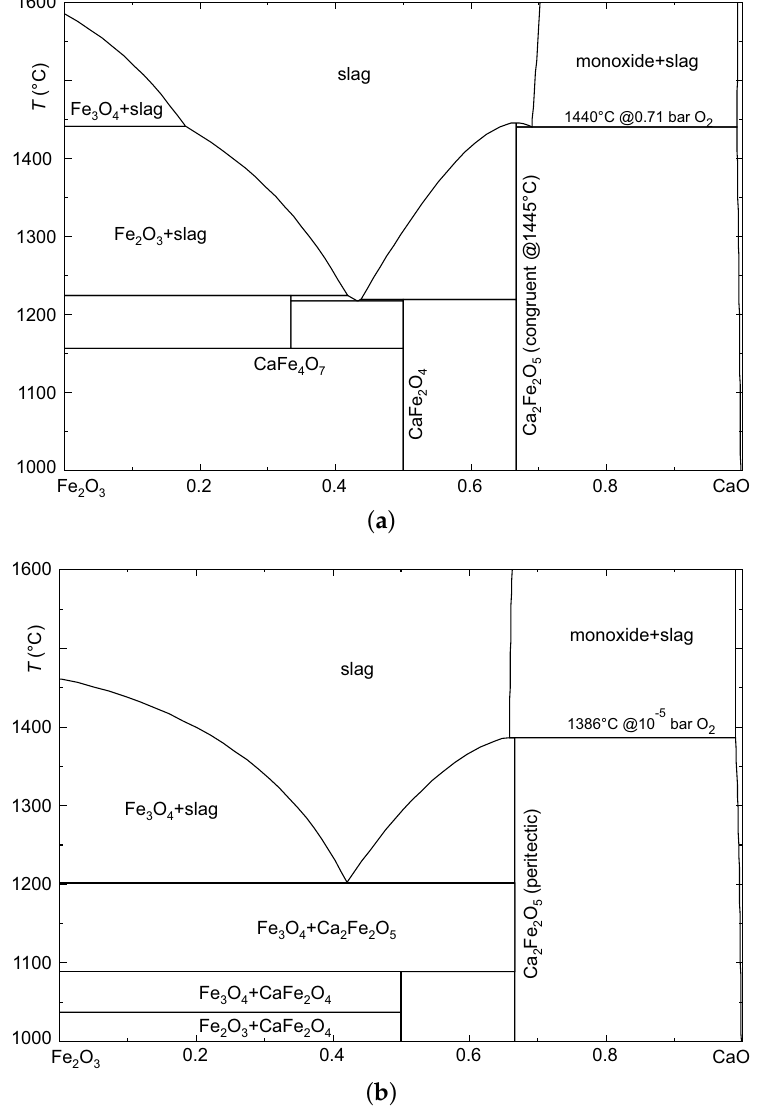
Figure 4. Isopleth sections CaO–Fe 2 O 3 of the system FeO–Fe 2 O 3 –CaO, calculated for different atmospheres with FactSage [7]. ( a ) Calculation for p O and the eutectic toward CaO is at T eut = 1440 °C. ( b ) Calculation for p O melts incongruently under the release of CaO(ss) at T inc = 1386